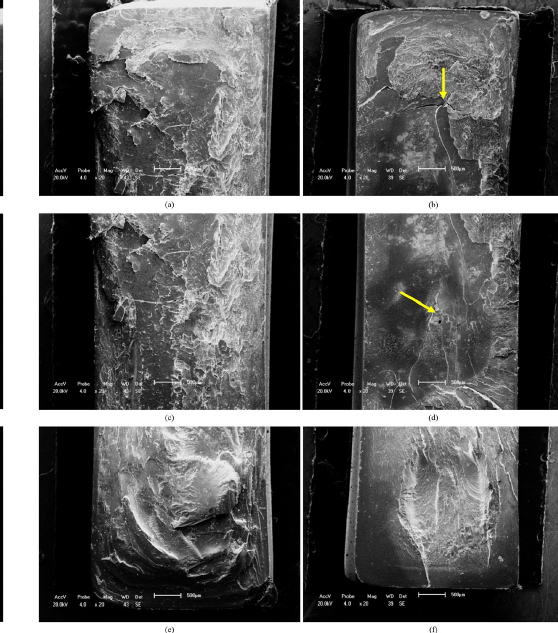
Figure 13. Scanning electron microscopy of PHB-1 fractured bar surface exposed to NaOH, during stress relaxation tests. Images (a), (c), (e): upper border, middle and lower border of the bar, respectively, with applied load of 275 N. Images (b), (d), (f): upper border, middle and lower border of the bar, respectively, with applied load of 824